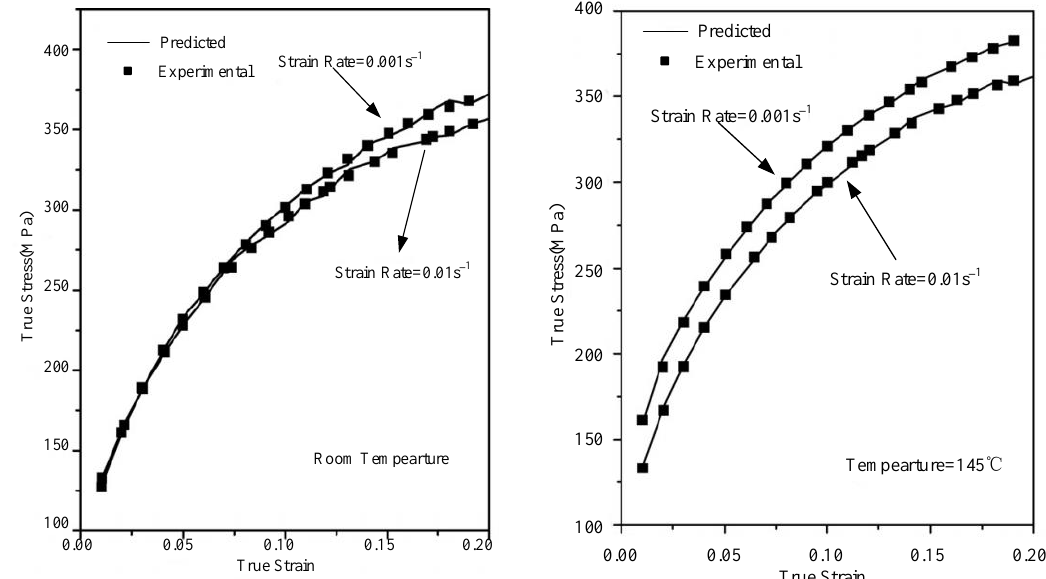
Figure 23. Comparison of prediction results between experimental data and non-sampling results [65].